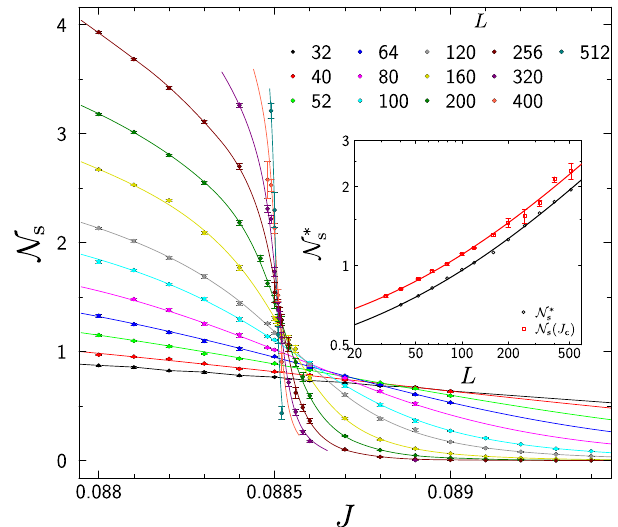
FIG. 5. Spanning number N as a function of J , for various L . s Inset: L dependence of critical spanning number N (cid:2) , defined s (1) as N at J ¼ J (red dots) and (2) as N at the point where the c s s = d J j is maximal (black dots). Continuous curves are slope j d N s AL p þ B , with exponents p ¼ 0 . 61 ð 5 Þ and power-law fits, N (cid:2) s ¼ p ¼ 0 . 62 ð 3 Þ , respectively. (Note log-log